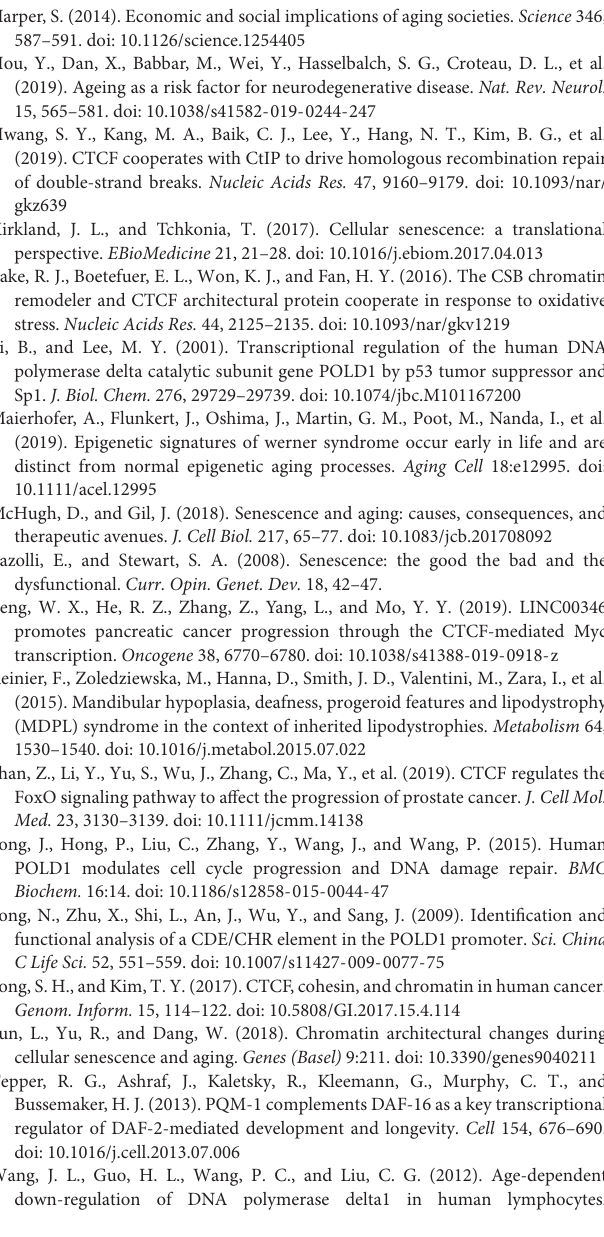
Supplementary Figure 1 | Metformin could act as agonist of CTCF to delay cell senescence. (A) Protein expression of CTCF, POLD1, and p16 INK4a in 2BS cells treated with 4 mM metformin for 24 h. (B) SA- β -gal staining of 2BS cells treated with 4 mM metformin for 24 h. (C) EdU-positive cells were quantified after 24 h of treatment by the ratio of the absorbance at 370 nm. Data were compared by Student’s t -test, and data are shown as the mean ± SEM, with three independent experiments in each group. * P < 0.05, *** P <